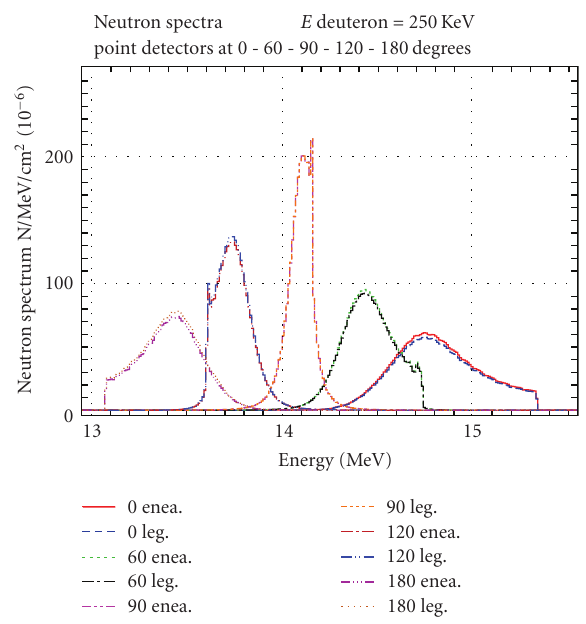
Figure 4: Neutron spectra calculated with the original and ENDF/B-VII